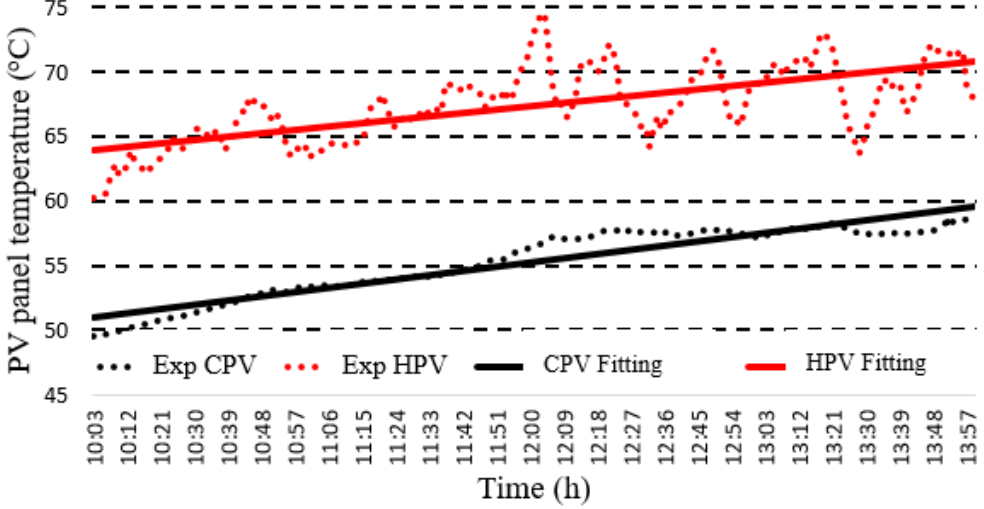
Figure 5. Temperature difference between the cooled panel and reference panel, the 30 July.